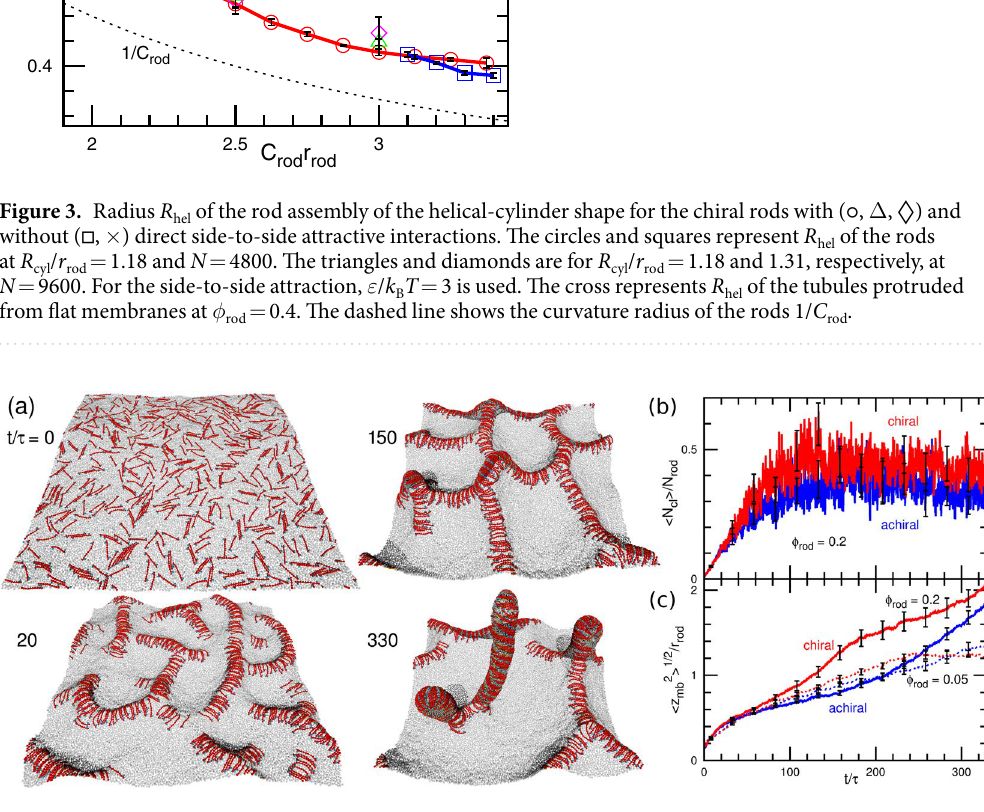
Figure 4. Tubulation from tensionless flat tensionless membrane. ( a ) Sequential snapshots for the high rod density φ rod = 0.2 and C rod r rod = 2.5 at t / τ = 0, 20, 150, and 330. ( b , c ) Time development of ( b ) mean cluster size 〈 〉 N and ( c ) vertical membrane span 〈 〉 z mb2 1/2 . The red and blue lines show the data for the chiral and achiral cl rods, respectively. The solid lines show the data for φ rod = 0.2 and C rod r rod = 2.5. The dashed lines in ( c ) show the data for the low density φ rod = 0.05 and C rod r rod =